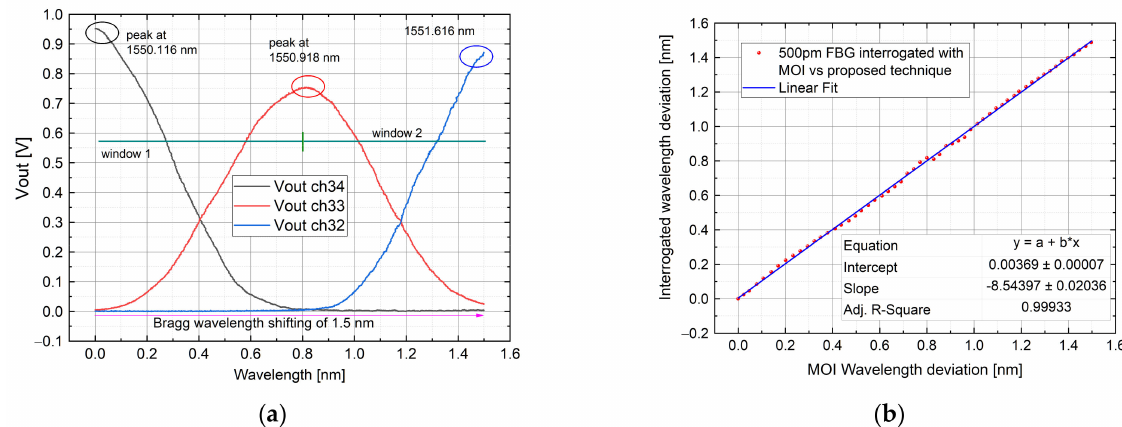
Figure 10. As the last test, the interrogation of a 500 pm bandwidth FBG among AWG channels 34, 33 and 32 is shown with: Channel output voltage ( a ); interrogated wavelength with a commercial system vs. proposed one compared with a linear fit in a dynamic range of 1.5 nm ( b